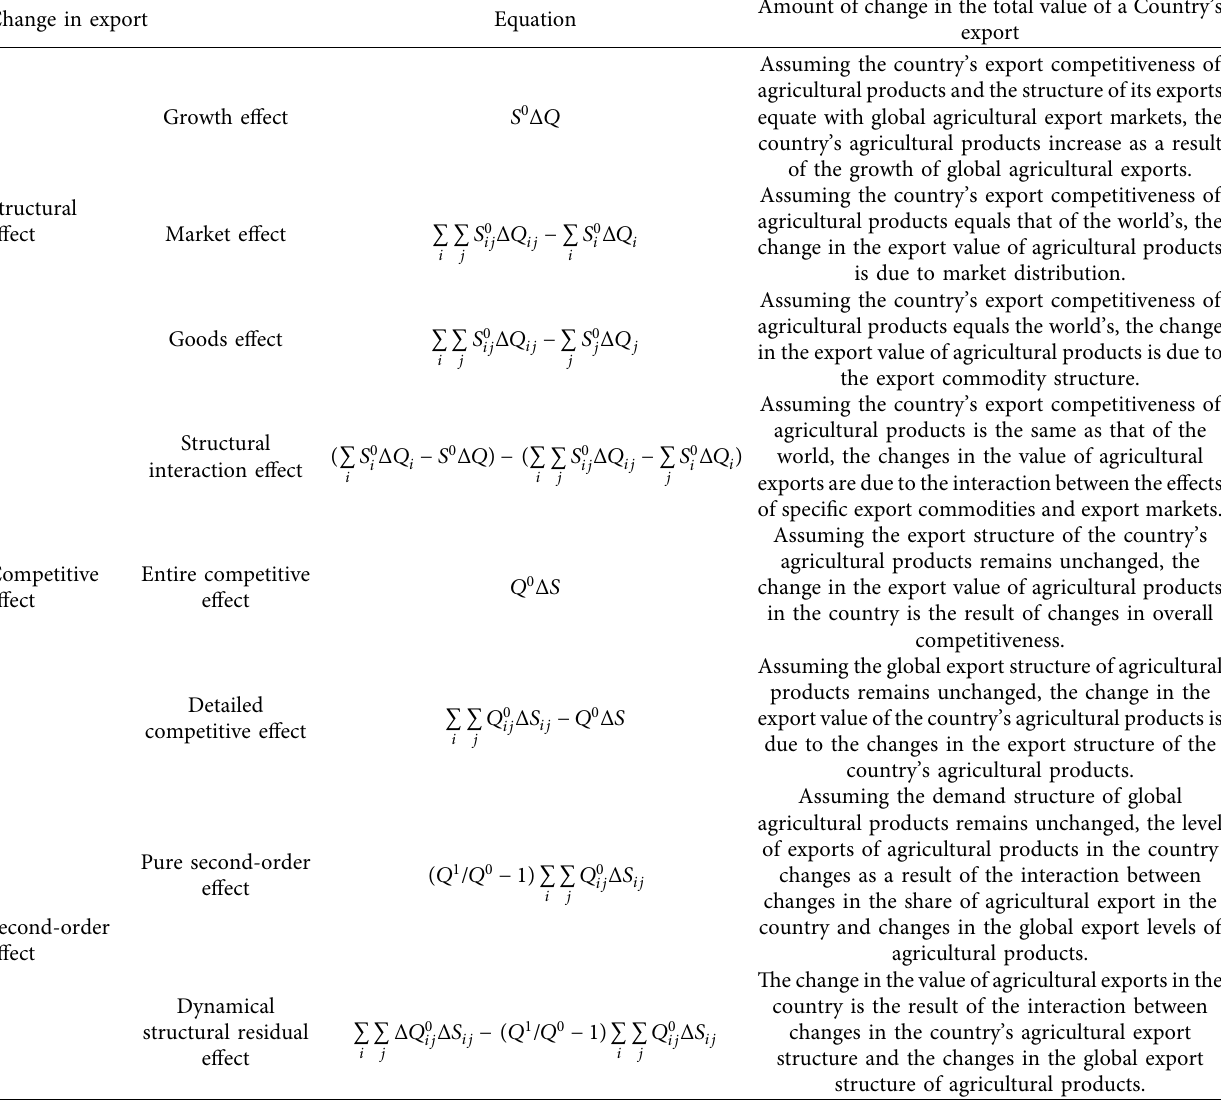
Table 1: Detailed meanings of different parts of equation